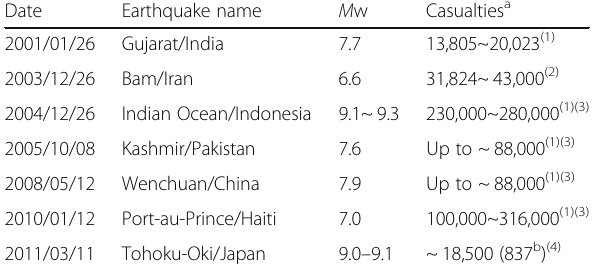
Table 1 Seven deadliest earthquakes in the twenty-first century